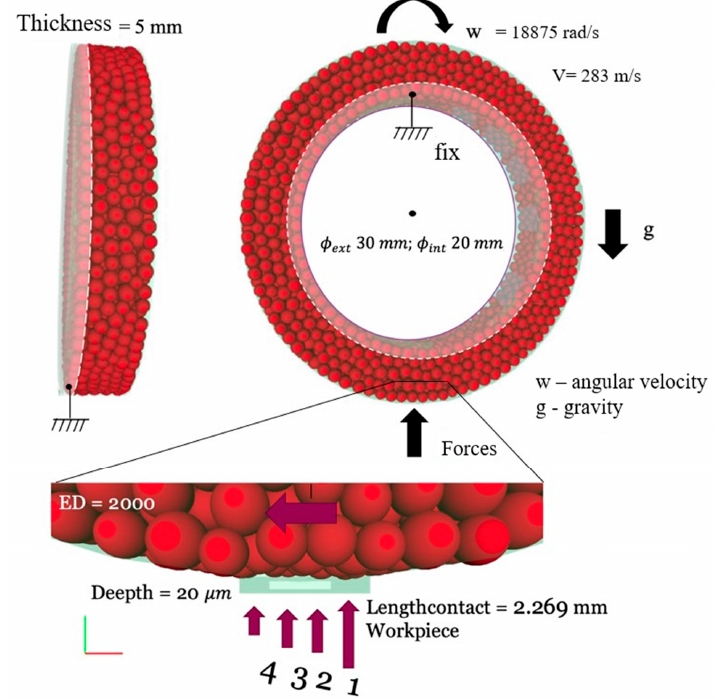
Figure 2. The discrete element method DEM model of a high-performance alumina grinding